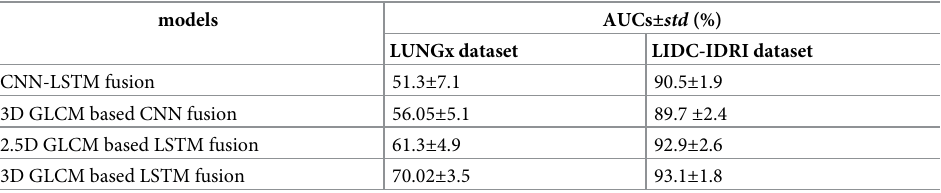
Table 5. The classification results in terms of micro-averaged AUCs trained on the LIDC-IDRI dataset and tested on LIDC-IDRI and LUNGx datasets for the proposed and baseline models.